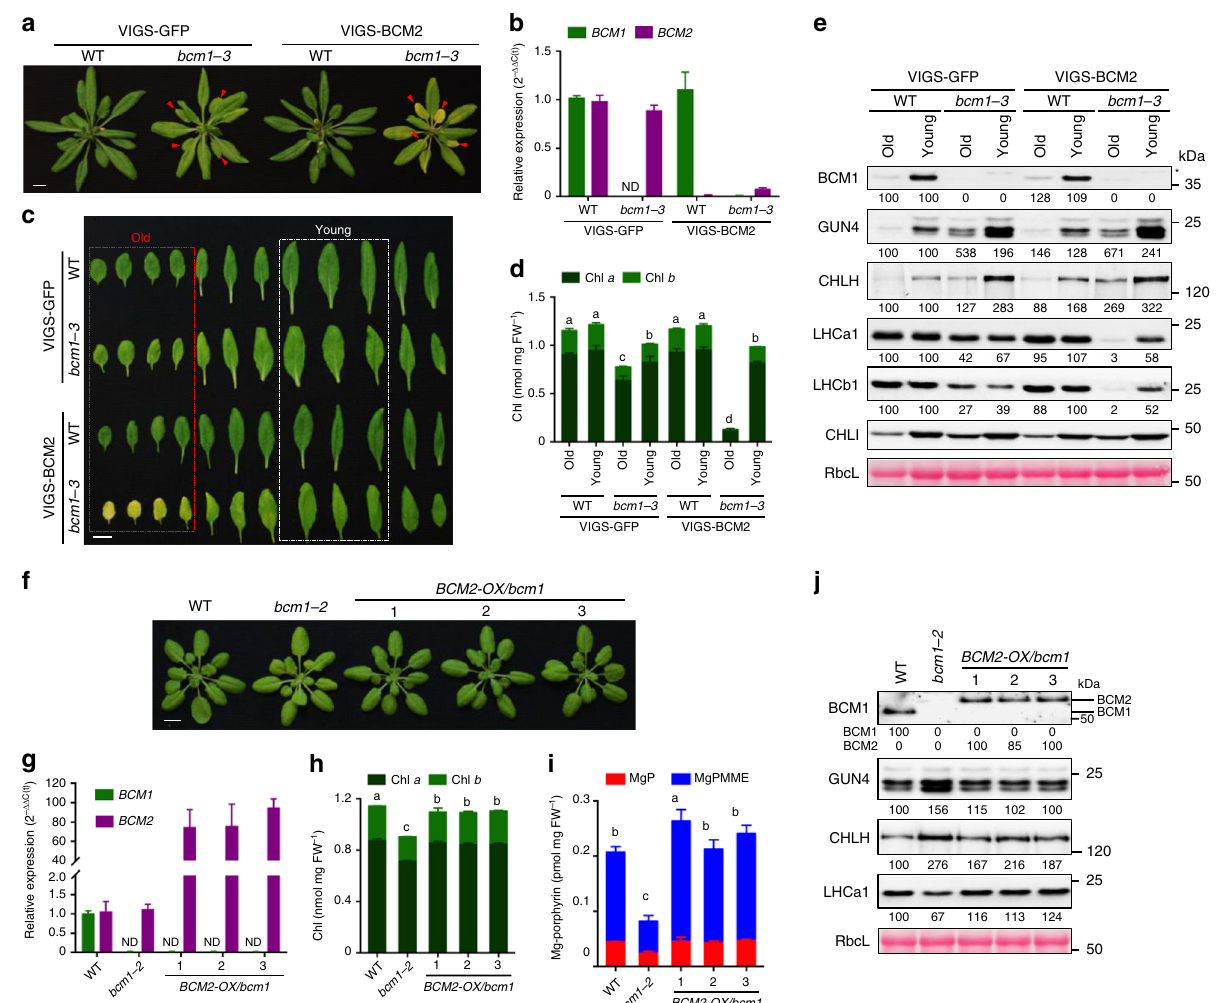
Fig. 5 BCM2 plays a conserved role in Chl biosynthesis. a Representative images of 35-day-old VIGS-GFP (as the negative control) and VIGS-BCM2 seedlings, which were infected with the pTRV2-GFP and pTRV2-BCM2 vectors via agroin fi ltration in the WT and bcm1-3 background, respectively. The VIGS seedlings were grown under long-day normal light (120 μ mol photon m − 2 s − 1 ) conditions. The old leaves were indicated by red arrows. b qRT-PCR analysis of BCM1 and BCM2 transcripts in the seedlings shown in a . c Representative images of detached leaves from seedlings shown in a . The old and young mature leaves selected for further analyses were marked by red and white dotted frames, respectively. d Levels of Chl in the old and young leaves shown in c . e Steady-state levels of the indicated proteins in the old and young leaves analyzed in c were determined by immunoblot analysis using the indicated antibodies. f Representative images of 28-day-old WT, bcm1-2 , and three independent BCM2-OX/bcm1 transgenic lines overexpressing BCM2 in the bcm1-2 background grown under short-day normal light (120 μ mol photon m − 2 s − 1 ) conditions. g qRT-PCR analysis of BCM1 and BCM2 transcripts in the seedlings shown in f . Expression levels are presented relative to those in WT seedlings. h , i Levels of Chl ( h ) and Mg-porphyrin ( i ) in 18-day-old WT, bcm1-2 and BCM2-OX/bcm1 seedlings grown under short-day normal light (120 μ mol photon m − 2 s − 1 ) conditions. j Steady-state levels of the indicated proteins in seedlings analyzed in h were determined by immunoblot analysis using the indicated antibodies. In a , c , f , scale bars, 1 cm. In b , g , expression levels are presented relative to those in the VIGS-GFP/WT and WT seedlings, respectively. ND, not detected. In b , d , g – i , error bars represent SD of three biological replicates. Letters above histograms indicate signi fi cant differences determined by Tukey ’ s HSD method ( P < 0.05). In e , j , Ponceau S-stained RbcL was used as the loading control. Numbers below immunoblots represent normalized protein abundances relative to WT seedlings. Asterisks indicate nonspeci fi c signals on the